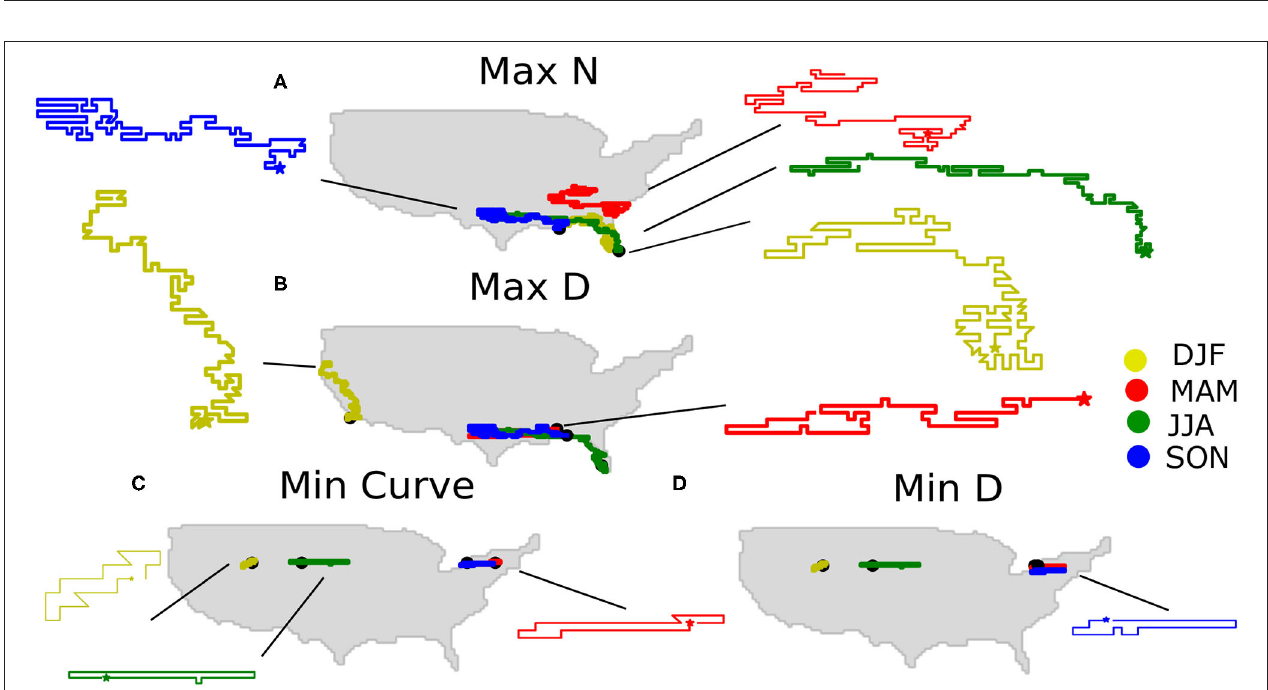
FIGURE 3 | Examples of maximum and minimum precipitation chain properties. (A) Maximum length in grid cells, N , (B) maximum distance, D , from start (indicated by stars) to end point in km, (C) minimum C , where C is defined as D